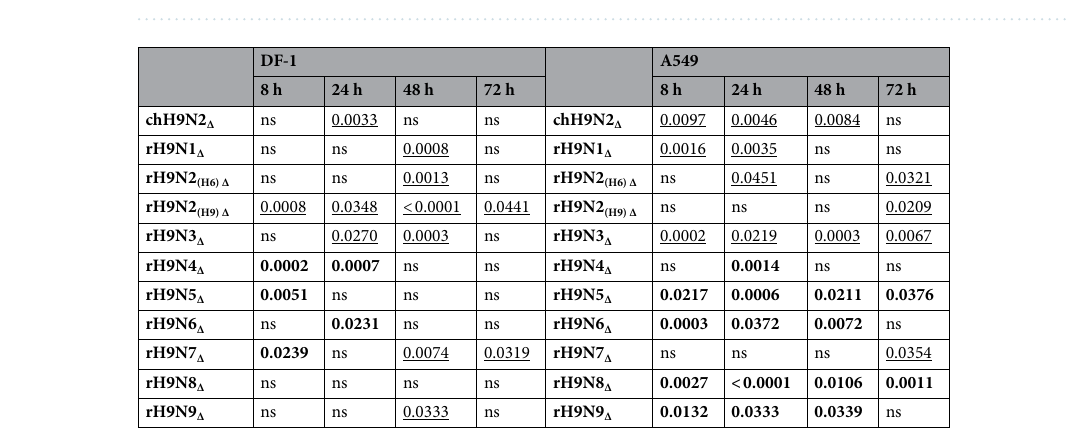
Table 4. List of p-values generated from Tukey multiple comparison of the replication kinetics data, comparing the mean TCID 50 between rH9Nx with neuraminidase stalk-deletion and parental chH9N2 virus in both DF-1 and A549 cells. P-values less than 0.05 were considered significant. Bold p-values indicate significantly higher mean TCID 50 value at a given timepoint. Underlined p-values indicate significantly lower TCID 50 at a given timepoint. Non-significant comparisons are denoted